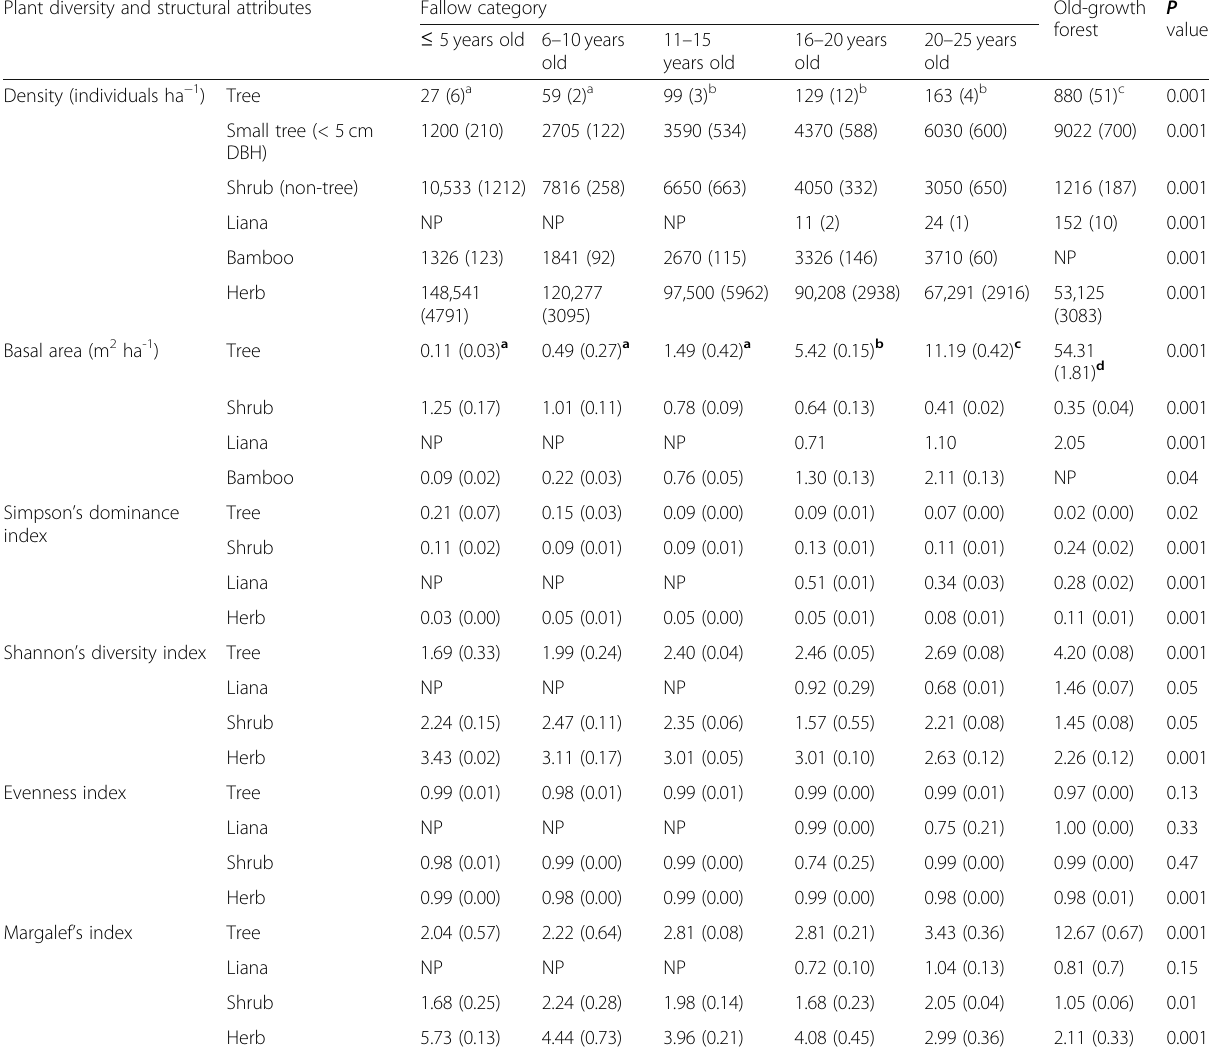
Table 2 Within and between variations of plant diversity and structural attributes across the differently aged jhum fallows and the old-growth forest Plant diversity and structural